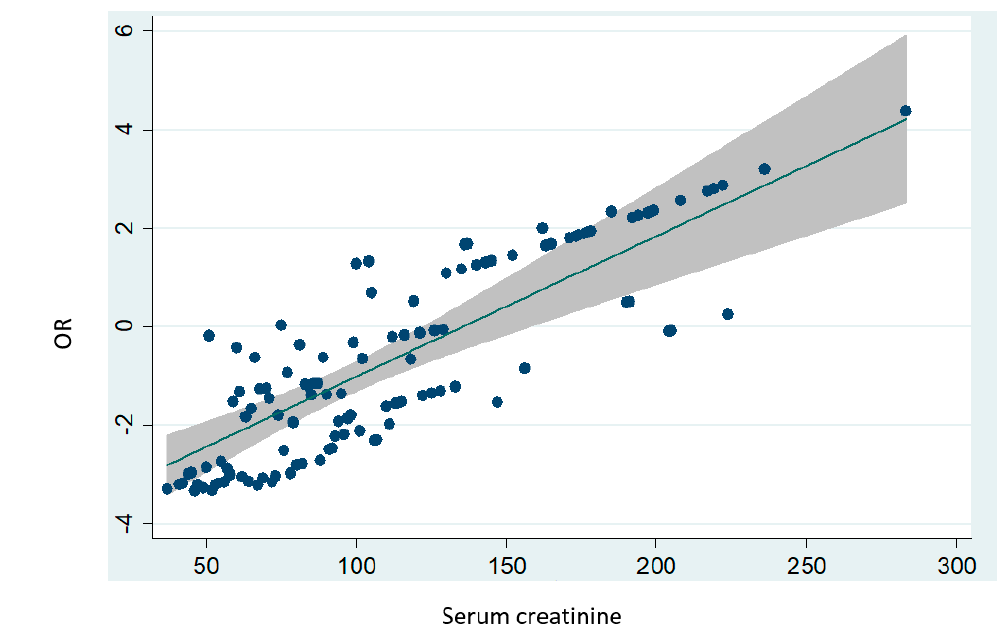
Figure 2. Odds ratios for post-operative acute kidney injury according to pre-operative serum creatinine levels.